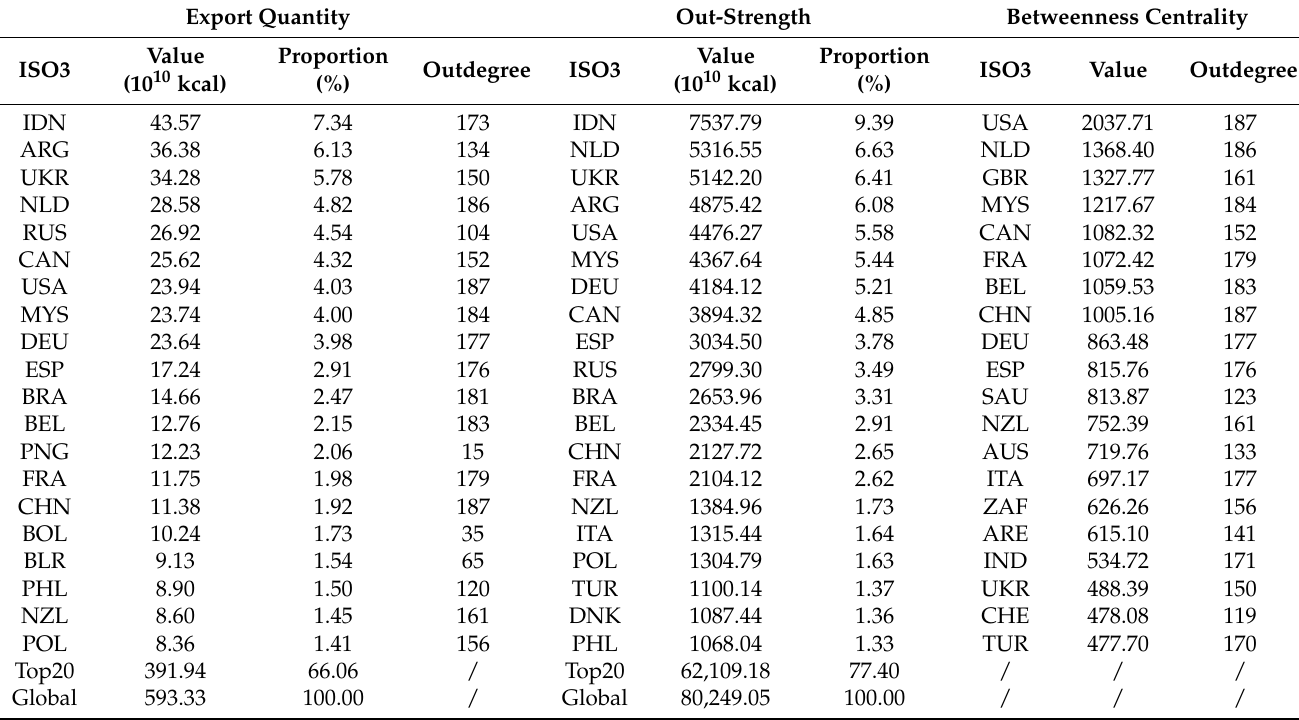
Table 3. Characteristics of the top 20 countries in the CCFTN.